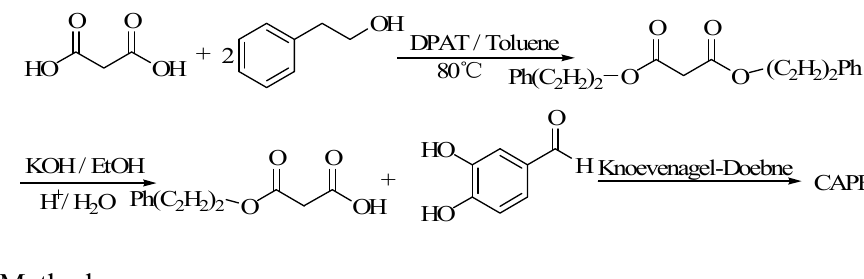
Figure 6. The scheme of method of malonic acid monoester.